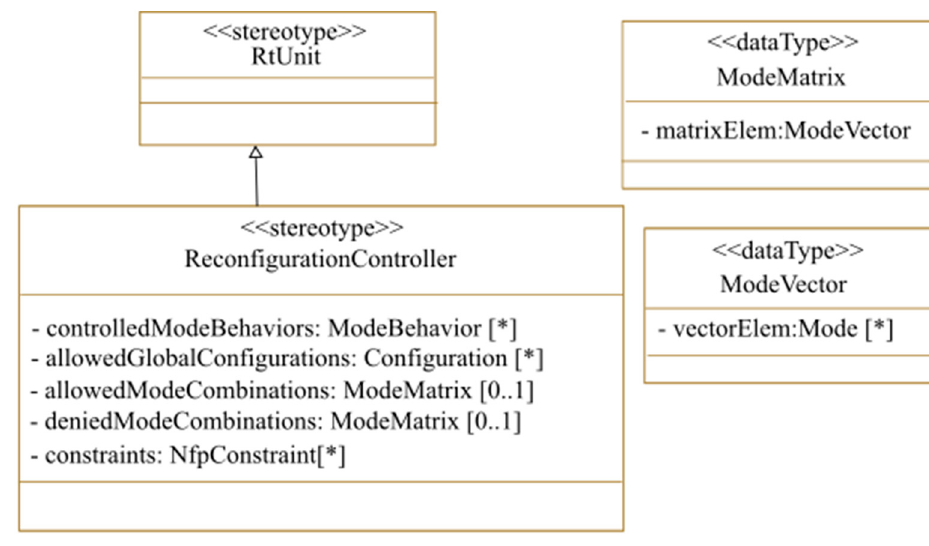
Figure 3. Reconfiguration controller stereotype, (* UML Syntax that means zero or more).